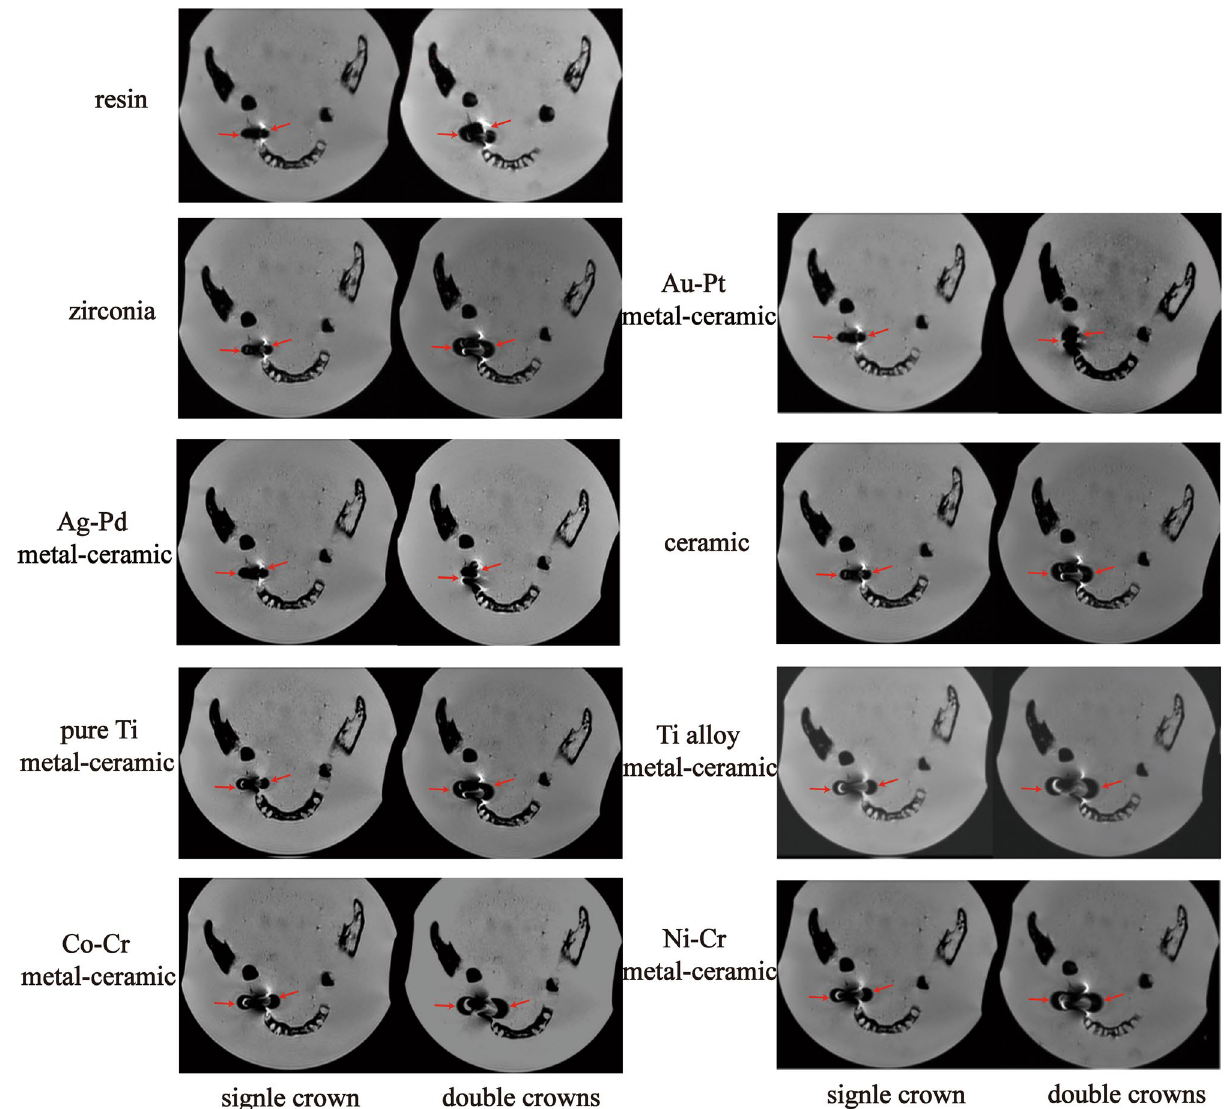
Figure 7. Images of the artifacts produced by one or two titanium restorations with nine different materials in the dry human mandible in FRFSE-T2WI (red arrows indicate the